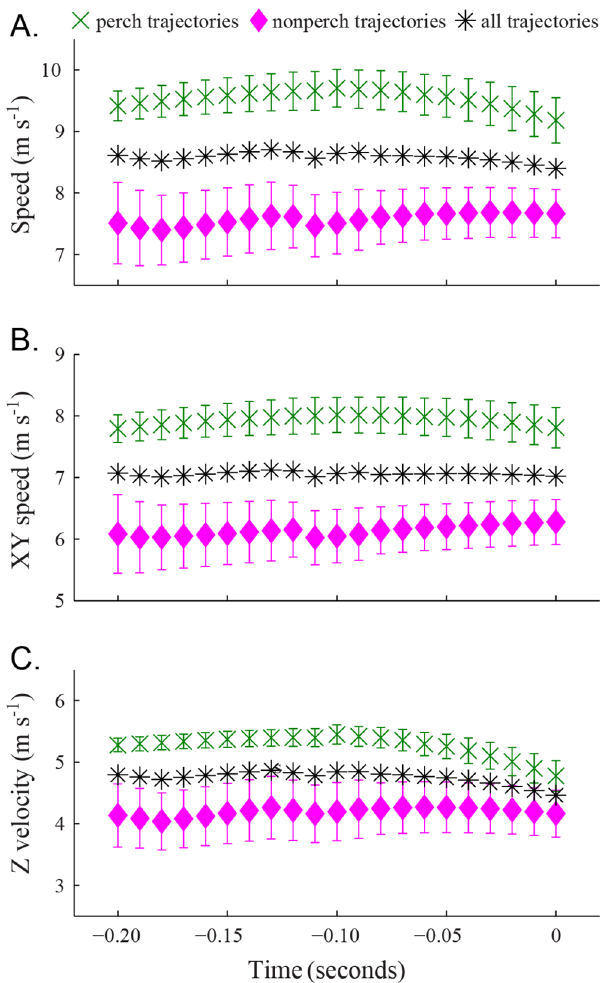
Fig 4. Flight speed in defending trajectories. The green cross markers show the mean flight speed of defending birds that approached the feeder from a frequently-used perch. Error bars show the standard error (n = 16 trajectories at t d = 0 and n = 15 at t d = 0.11 seconds). The pink diamond markers show the mean flight speed of all other defending trajectories (n = 17 at t d = 0, n = 15 at t d = 0.09 seconds, and n = 11 at t d = 0.11). The black asterisk markers show the mean flight speed of all defending birds (n = 33 at t d = 0, n = 30 at t d = 0.09, and n = 26 at t d = 0.20 seconds). (A) Gives the overall flight speed while (B) shows speed in the horizontal (XY) projection of the trajectories and (C) shows vertical velocity. Note that a positive vertical velocity is downward toward the ground and feeder. The trajectories were combined using a common t d where 0 is the time at which the trajectory passed through Z = -1.2